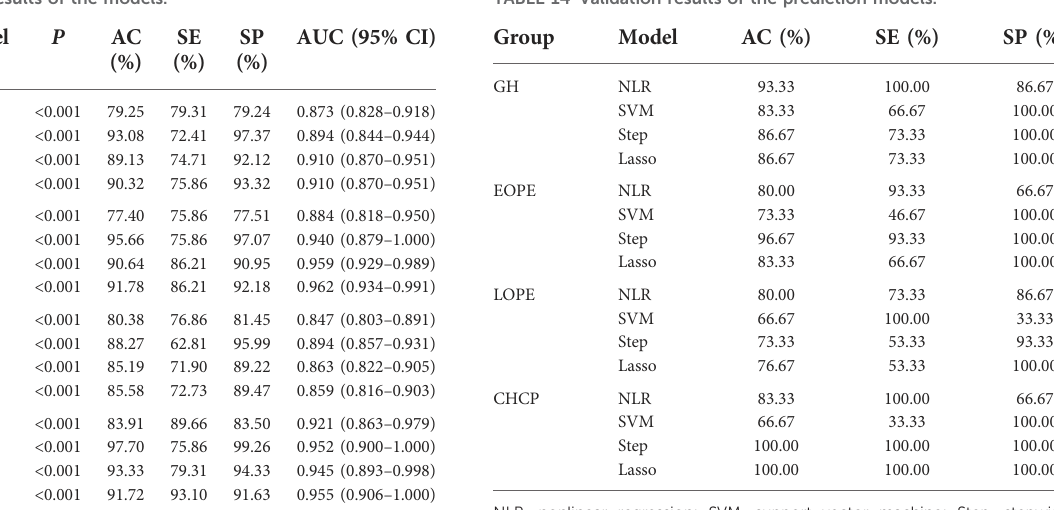
TABLE 14 Validation results of the prediction